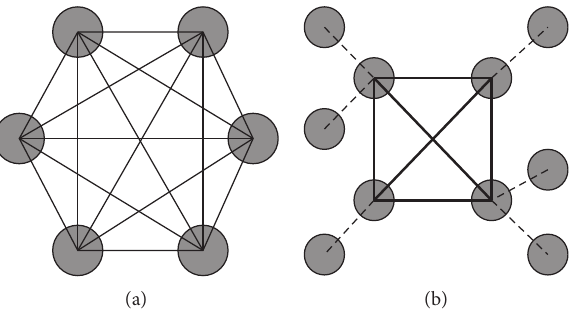
Figure 1: Comparison of hub-and-spoke network and fully connected network structure. (a) Fully connected network. (b) Hub-and-spoke